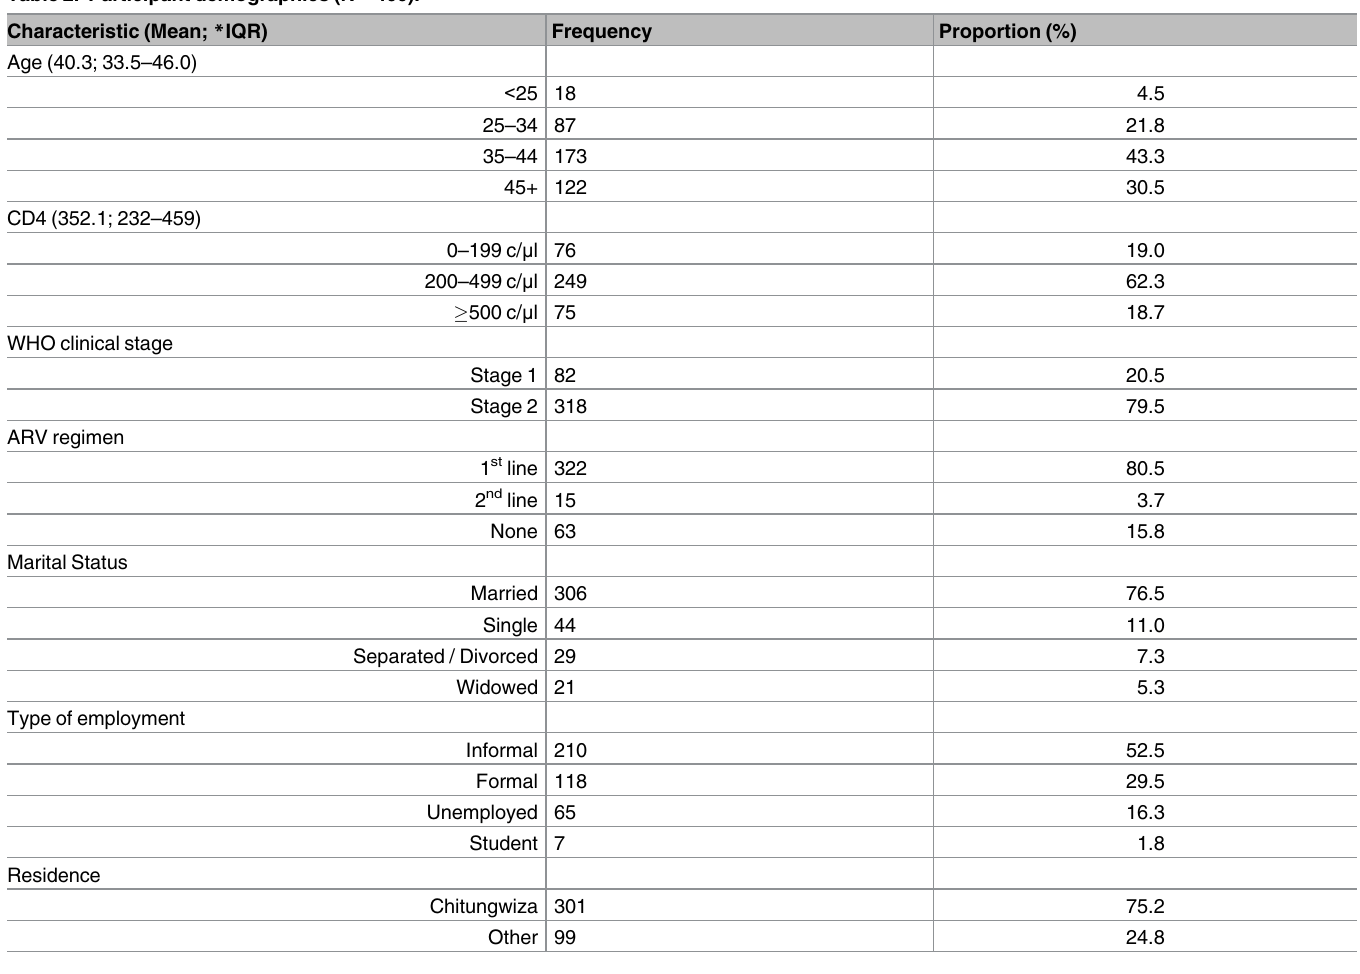
Table 2. Participant demographics (N = 400).